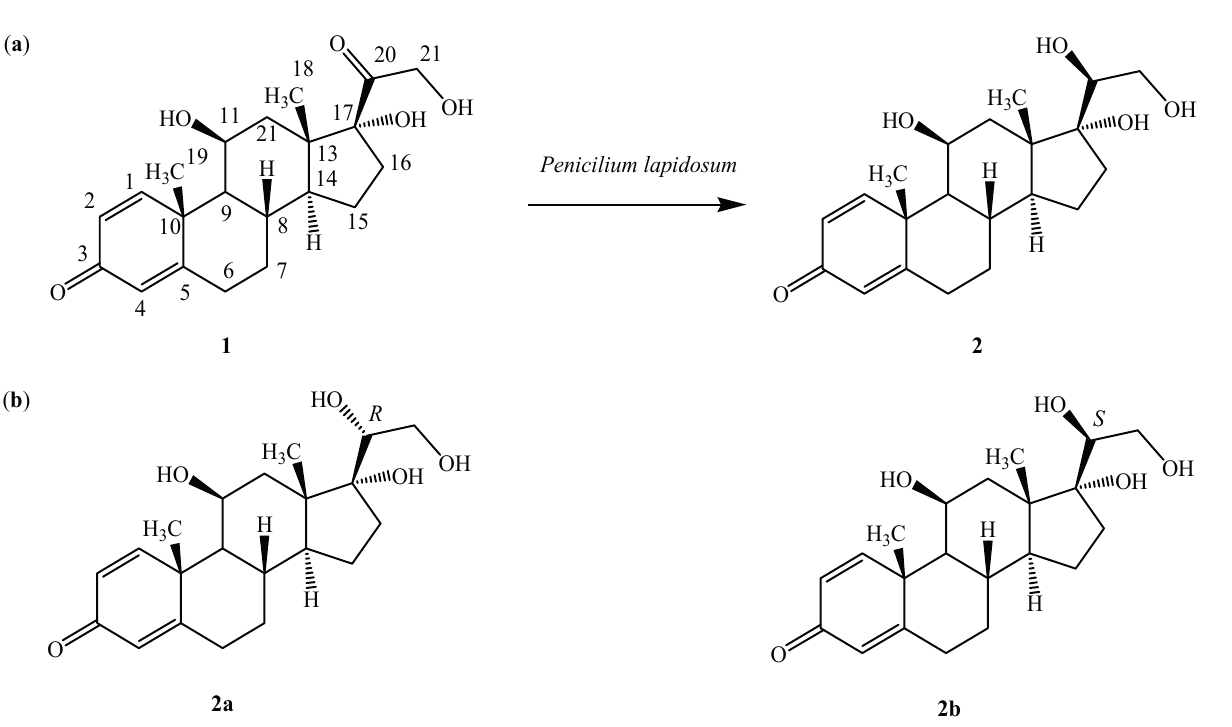
Figure 1. ( a ) Biotransformation of prednisolone ( 1 ) to 20 β -hydroxyprednisolone ( 2 ) by Penicilium lapidosum ; ( b ) molecular structures of stereoisomers 2a and 2b